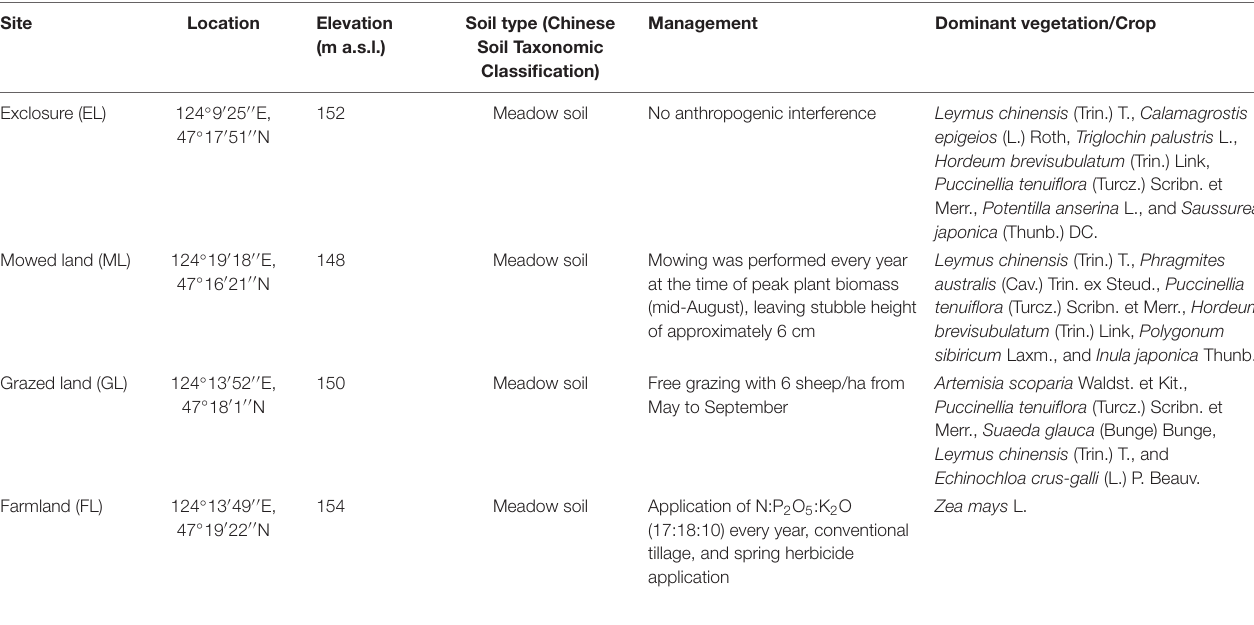
TABLE 1 | Site descriptions of the different land use